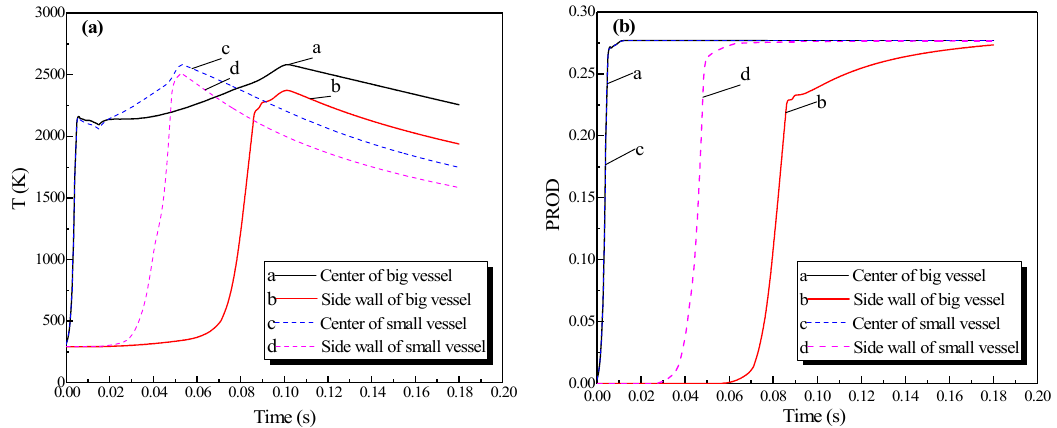
Figure 5. Profiles of the natural gas explosion parameters in the single vessel. ( a ) Profiles of explosion temperatures against time in the vessels; ( b ) concentration profiles against time for the explosion products in the vessels.